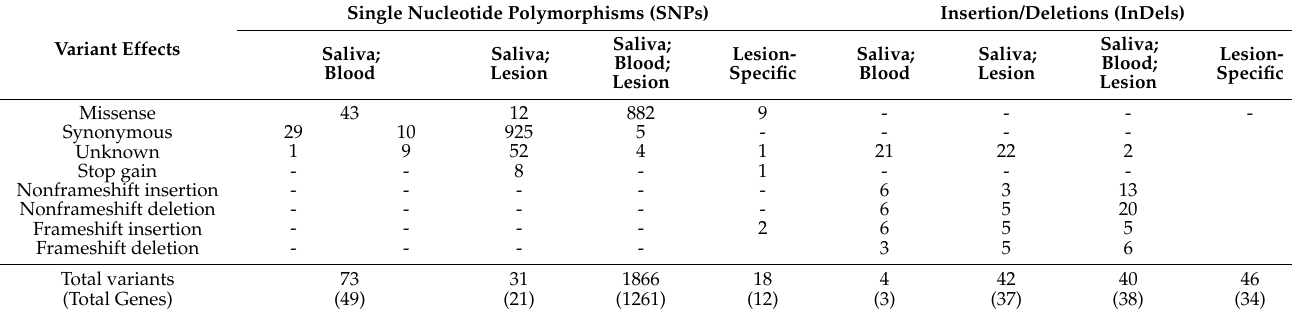
Table 3. Effects of variants in the exonic